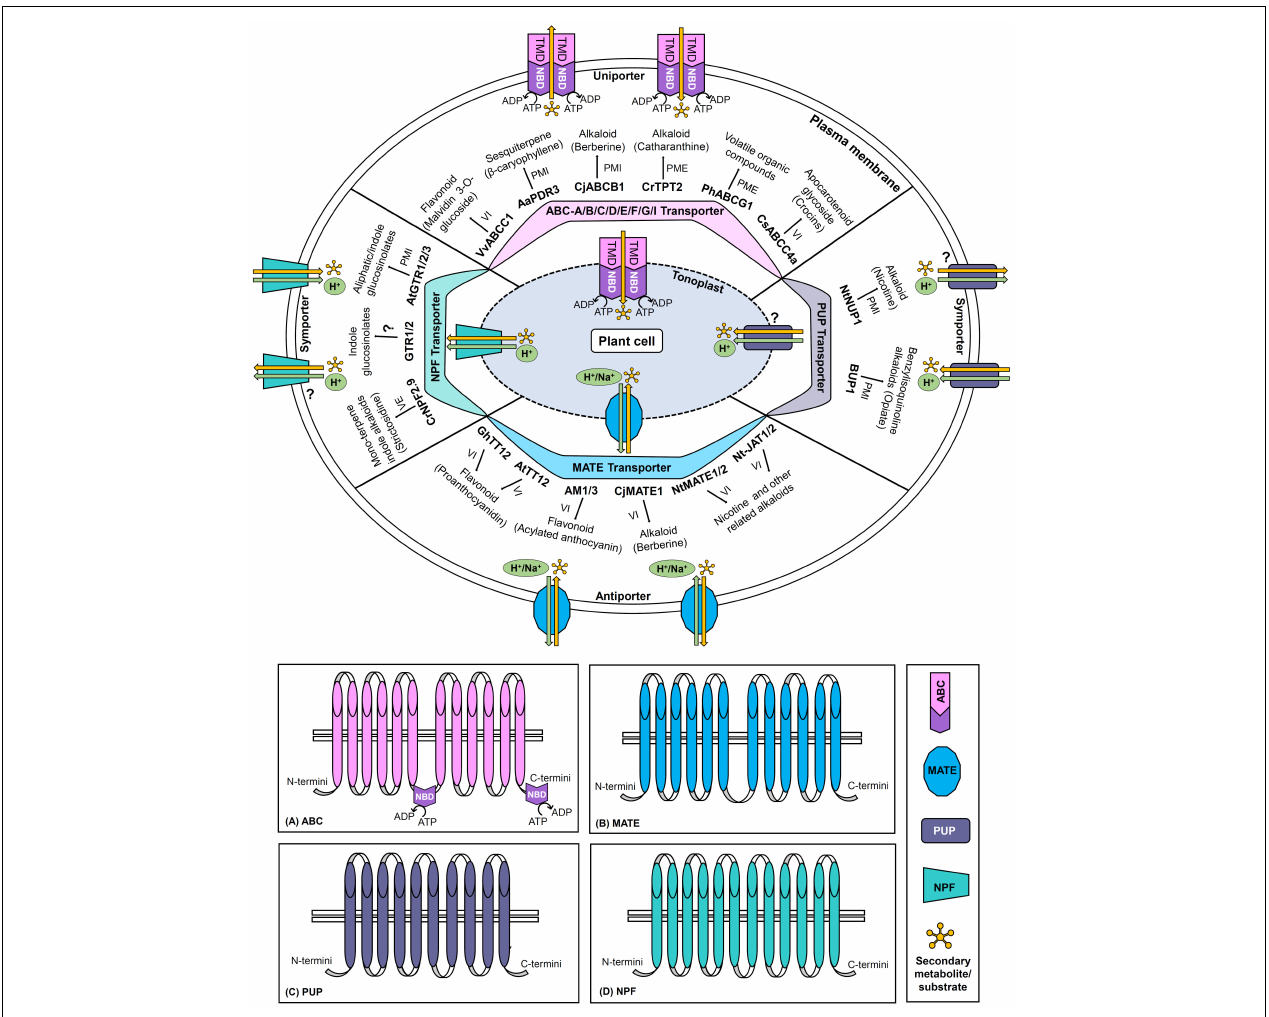
FIGURE 1 | Schematic representation of ABC, MATE, PUP, and NPF transporters. The diagram denotes transporter classification, localization (plasma membrane/tonoplast), general structure, directionality, energy source (ATP hydrolysis/proton or other cation gradients), domains and subfamilies (only for ABC transporter), and transport mechanisms (uniport/symport/antiport). For each category of the transporter family, important examples of plant secondary metabolite transporters along with their corresponding target metabolites are illustrated. The panels (A–D) represent the generalized topology of the transporters belonging to the ABC, MATE, PUP, and NPF families, respectively. ABC, ATP binding cassette; MATE, multidrug and toxic compound extrusion; NPF, nitrate and peptide transporter family; PME, plasma membrane exporter; PMI, plasma membrane importer; PUP, purine uptake permease; VE, vacuolar exporter; VI, vacuolar importer (? represents that enough information is not